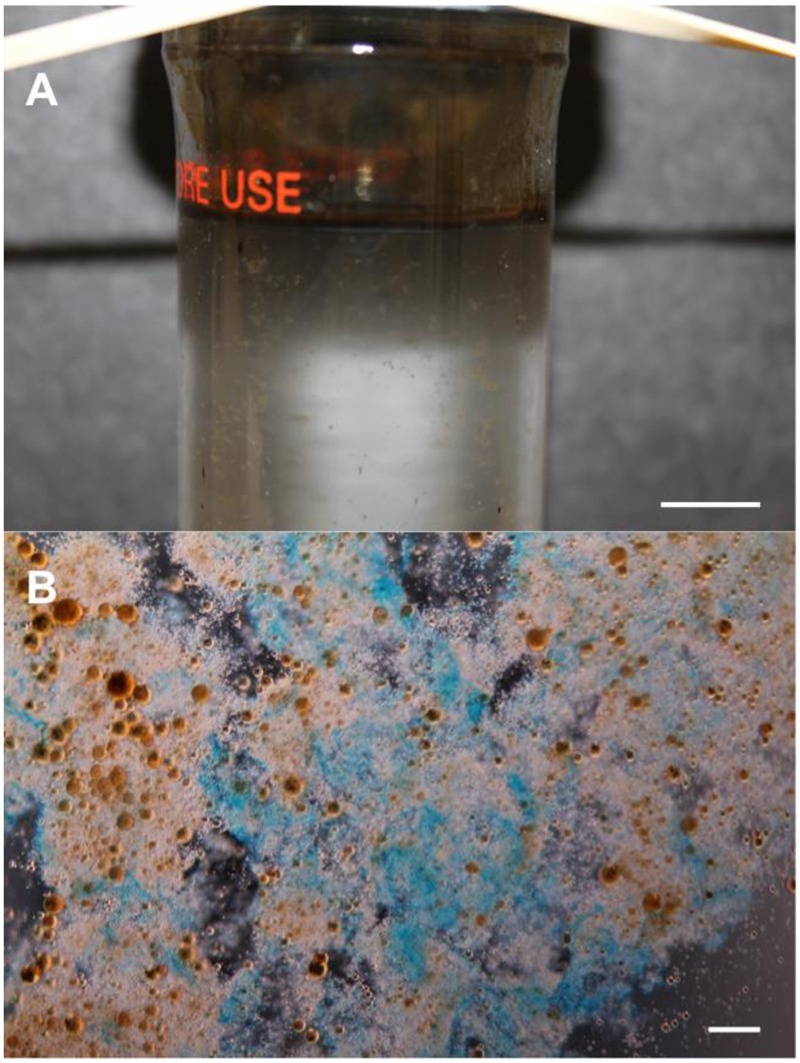
Formation of marine oil snow (MOS). (A) A roller-bottle incubation showing the formation of MOS in synthetic seawater amended with crude oil and inoculated with the EPS-producing (and oil-degrading) bacterium Alteromonas sp. strain TK-46(2) that was isolated from sea-surface oil slicks during the Deepwater Horizon oil spill. (B) Light micrograph of MOS aggregates, after staining with the cationic copper phthalocyanine dye Alcian Blue showing that the aggregates are partially composed of polysaccharide. The orange-brown spheres in (B) are emulsified oil droplets embedded within and adsorbed to the amorphous matrix of the aggregates. Scale bars = 10 mm (A), and = 10 μm (B).